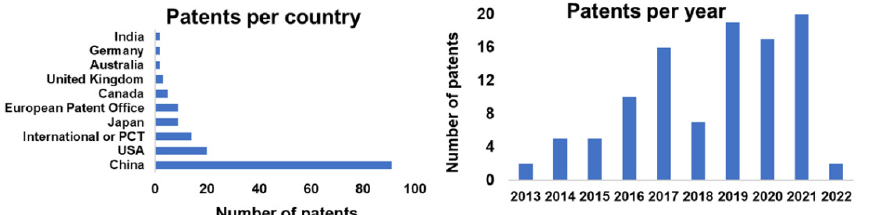
Figure 12. Summary of lignin-based polyurethane patents from 2013 to June 2022 obtained at the WIPO.